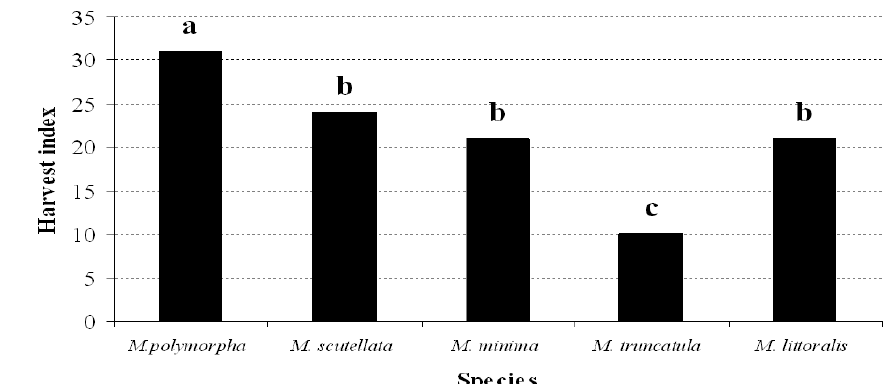
Fig. 12. Main effects of species on seed to burr ratio. All the values followed by the same letter in each column are not statistically different at the p<0.05 probability level